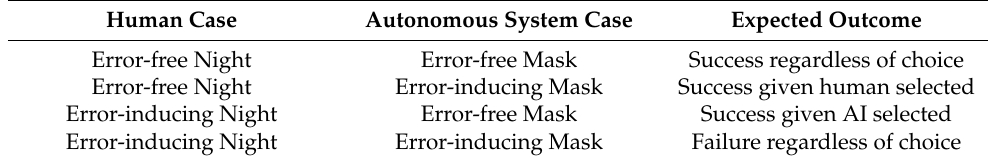
Table 6. Human–AI pair cases.